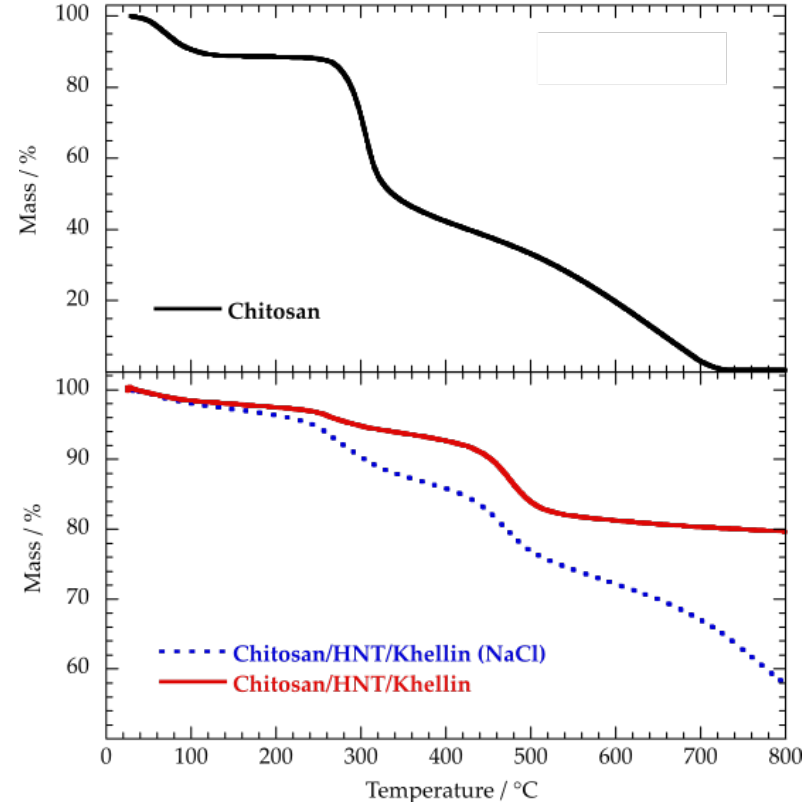
Figure 3. Thermogravimetric curves for chitosan and chitosan/HNT/khellin samples.